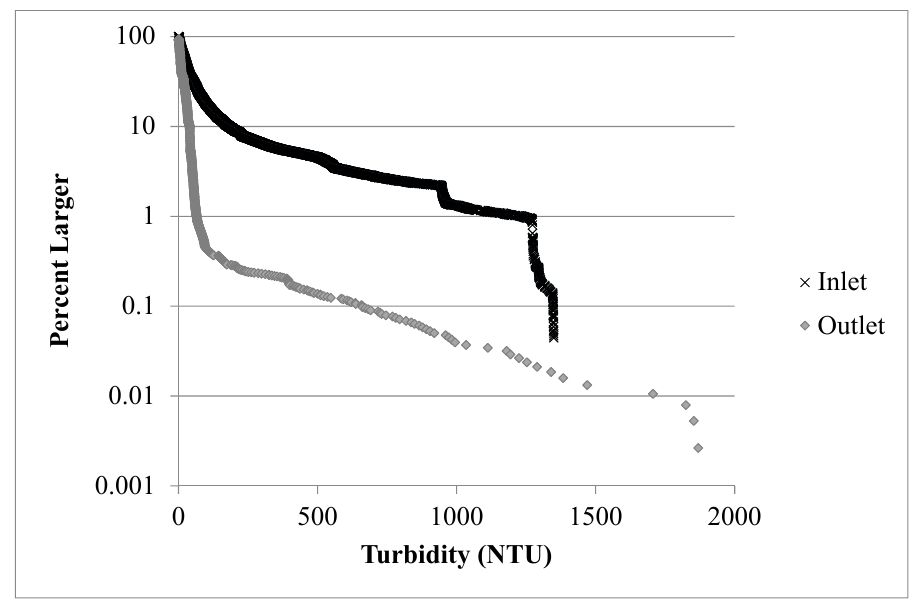
Figure 8. Probability plot of inlet and outlet turbidity for the entire monitoring period.